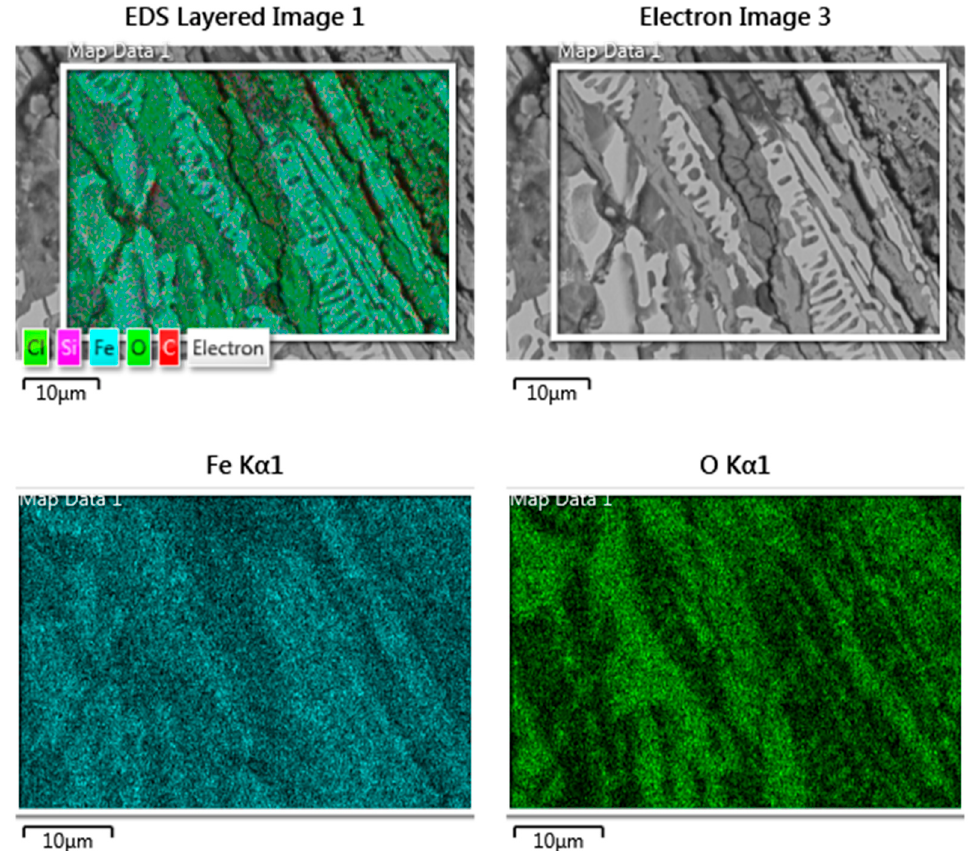
Figure 7. Distribution diagram of element at fractures in the iron matrix.